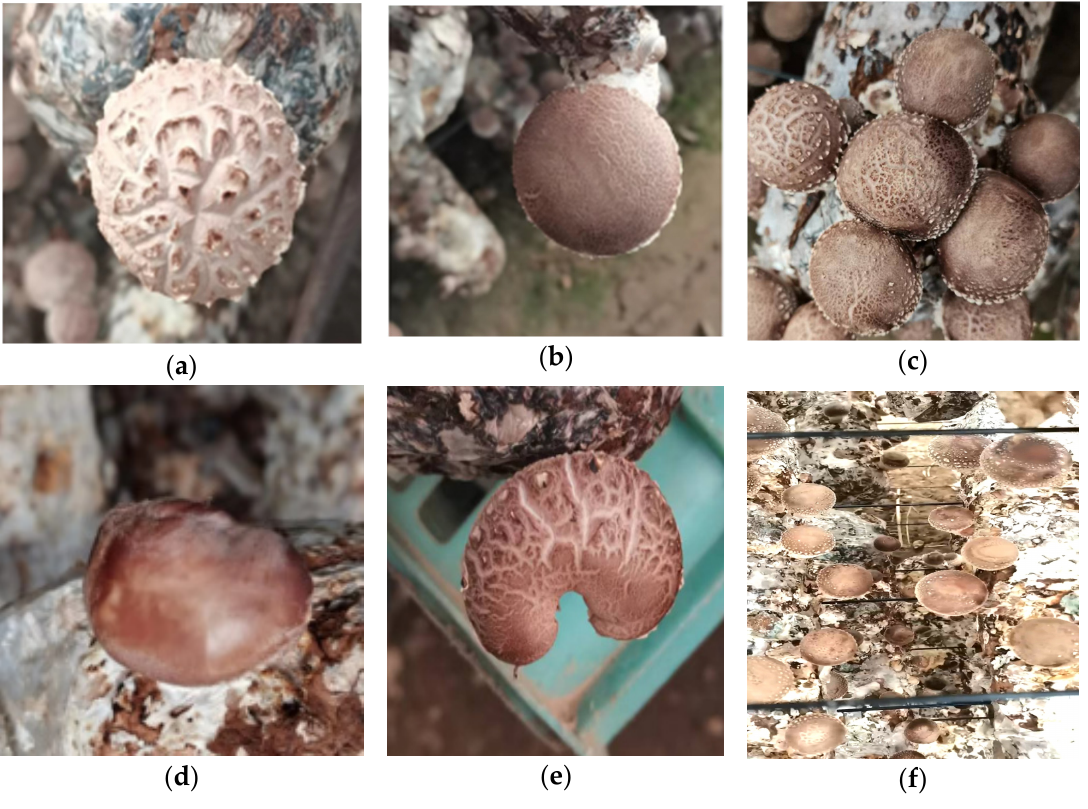
Figure 1. Varietal classification and shapes of various fresh shiitake mushrooms. ( a ) Cracked-surface mushroom; ( b ) Plane-surface mushroom; ( c ) Dense overlap; ( d ) Malformed plane-surface mushroom; ( e ) Malformed cracked-surface mushroom; ( f ) Large field of view.